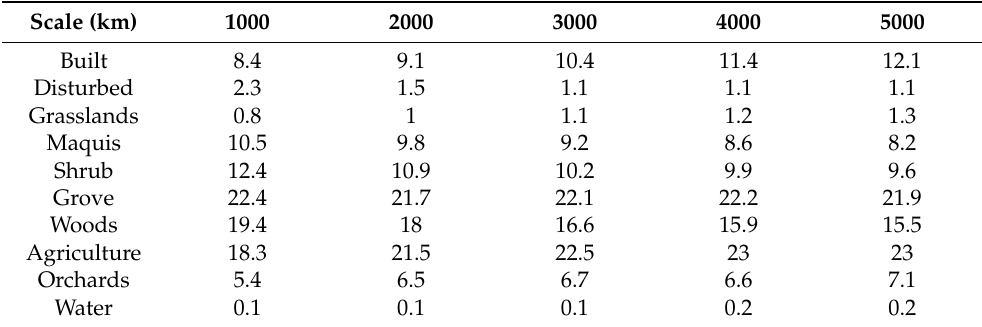
Table 1. Average proportion of land cover categories in spatial scales of 1000–5000 m radius around nest sites of eagle owls ( Bubo bubo